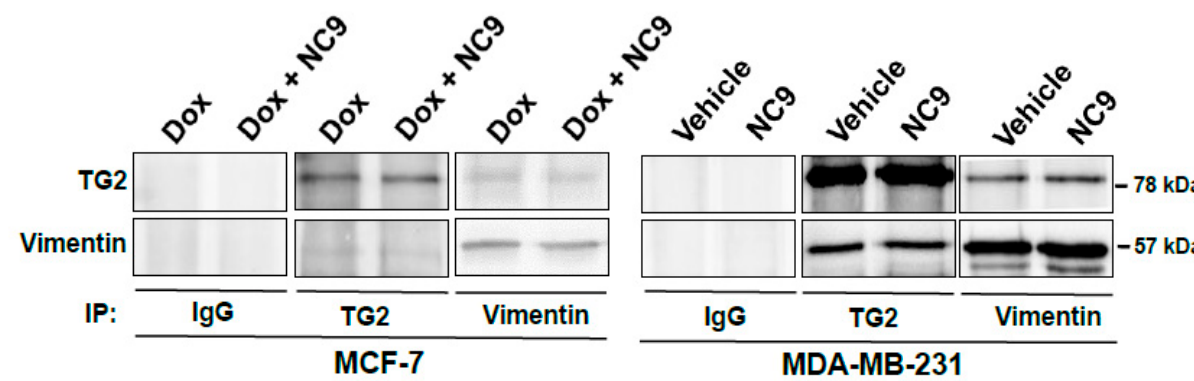
Figure 6. Representative Western blot analysis of TG2 and vimentin in immunoprecipitation from total lysates of MCF-7 treated with Dox and MDA-MB-231 cells in the presence or absence of NC9. Immunoprecipitation (IP) was carried out with specific antibodies against TG2 or vimentin. In addition, the control with a non-specific IgG.